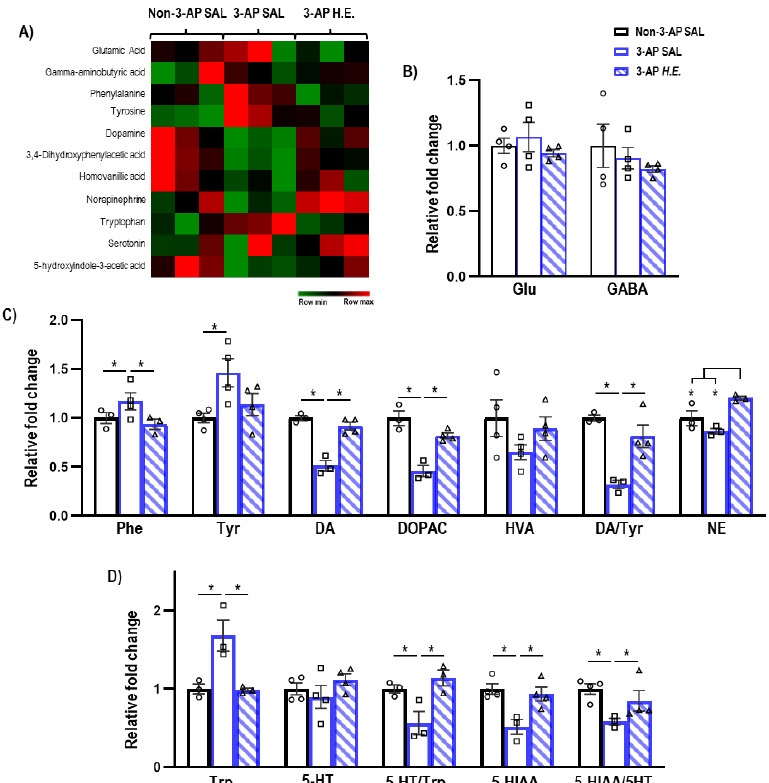
Figure 3. Mass spectrometry analysis of neurotransmitters and their metabolites in the cerebellum. ( A ) Heatmap of neurotransmitter expression in each group. ( B ) Relative expressions of glutamate and GABA. ( C ) Relative expressions of phenylalanine, tyrosine, dopamine, 3,4-dihydroxyphenylacetic acid (DOPAC), homovanillic acid (HVA), norepinephrine, and ratios of DOPAC/dopamine, HVA/dopamine, and dopamine/tyrosine. ( D ) Relative expressions of tryptophan, serotonin, 5-hydroxyindole-3-acetic acid (5-HITT), and ratios of serotonin/tryptophan and 5-HIAA/serotonin. Indicators: * p - values ≤ 0.05, Non-3-AP SAL group, 3-AP SAL group, 3-AP H.E. group.